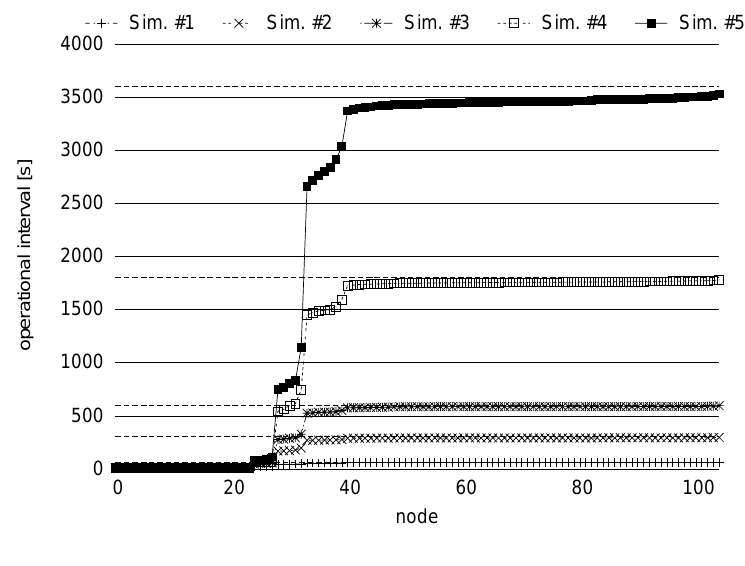
Figure 14. Operational interval with different operational